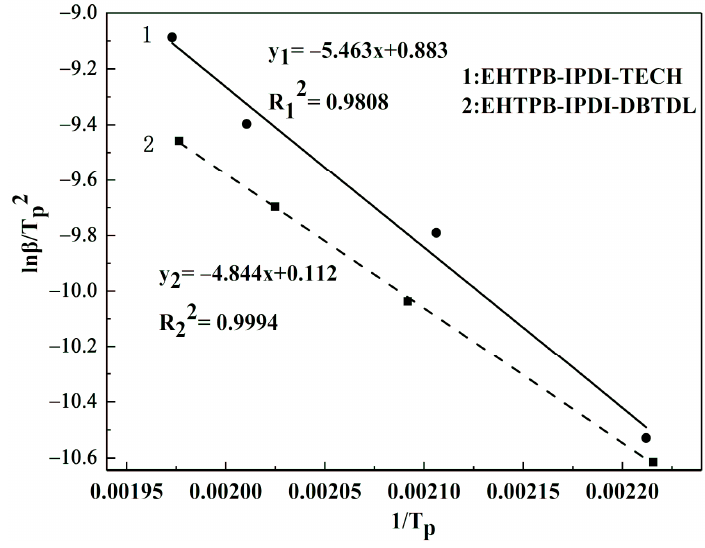
Figure 12. Fitting of the EHTPB-IPDI-DBTDL and EHTPB-IPDI-TECH systems by the Kissinger equation. Table 4. DSC data of the TECH-catalyzed and DBTDL-catalyzed EHTPB-IPDI curing reaction.